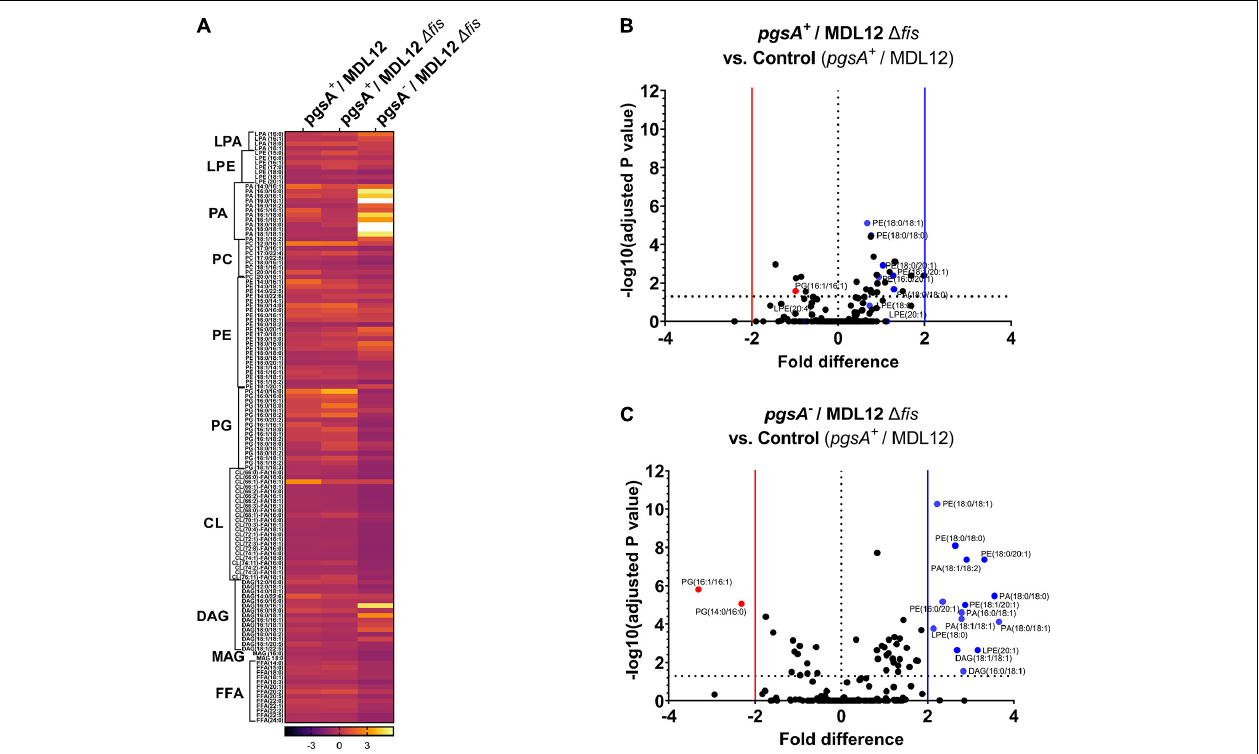
FIGURE 9 | Lipidomic analysis of MDL12 cells in the presence or absence of Fis. (A) Lipidomic analysis represented in heatmap comparing MDL12 cells with 1 mM IPTG for the expression of pgsA ( pgsA + / MDL12), MDL12 fis-null cells with 1 mM IPTG for the expression of pgsA ( pgsA + / MDL12 (cid:49) fis ), and MDL12 fis-null cells without expression of pgsA ( pgsA - / MDL12 (cid:49) fis ). Each row indicates the ratio values of individual lipid species for at least three biological replicates. ANOVA was performed to compare statistical differences between each group. Volcano plots comparing distribution of 191 lipids species among. (B) MDL12 fis-null cells expressing pgsA ( pgsA + / MDL12 (cid:49) fis ) and control [MDL12 cells expressing of pgsA ( pgsA + / MDL12)]. (C) MDL12 fis-null cells without expression of pgsA ( pgsA - / MDL12 (cid:49) fis ) and control [MDL12 cells expressing of pgsA ( pgsA + / MDL12)]. Horizontal dotted line indicates statistical significance with p = 0.05 for at least three biological replicates. A vertical red line separates red dots indicating data points with statistically significant fold decrease. A vertical blue line separates blue dots, indicating data points with statistically significant fold